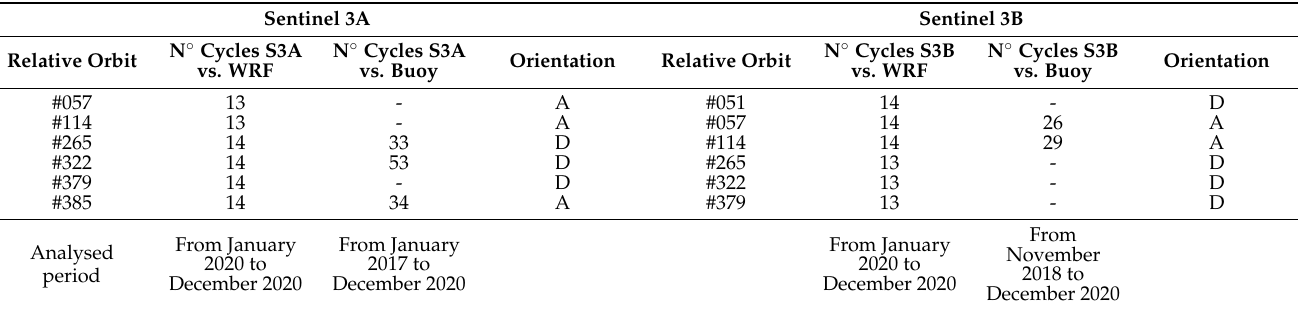
Table 1. Sentinel-3 A/B data availability (number of cycles, relative orbits and orientation) for the different comparisons among the datasets (the orientation of the different tracks is presented as ascending (A) or descending